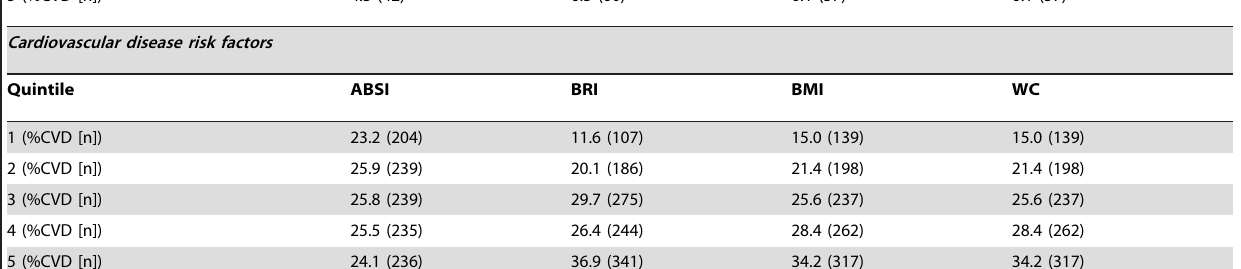
Cardiovasculardiseases